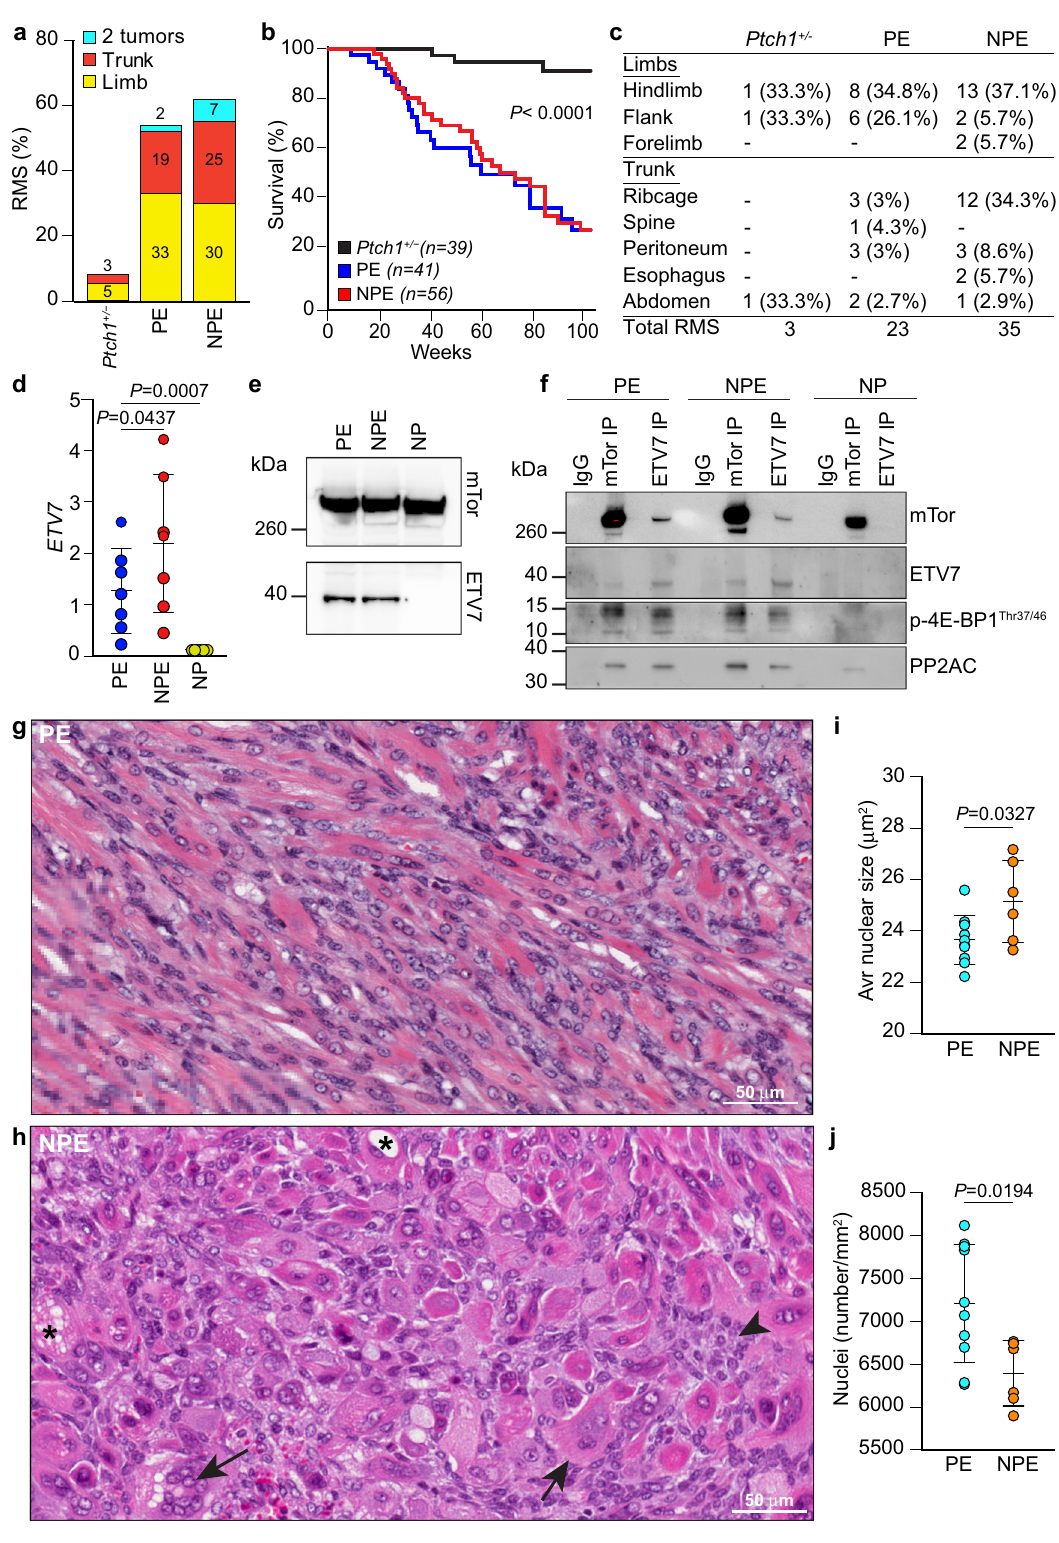
An algorithm designed to quantify nuclear morphometry in tumor H&E sections revealed an increased number of aberrantly large, multinucleated cells with atypical mitotic fi gures, pre- dominantly in NPE tumors (Fig. 1i). Because of the very large size of most of the nuclei in the NPE tumors, their total number per annotated area was lower than that in PE tumors (Fig. 1j). Instead, other typical RMS features were common to both NPE